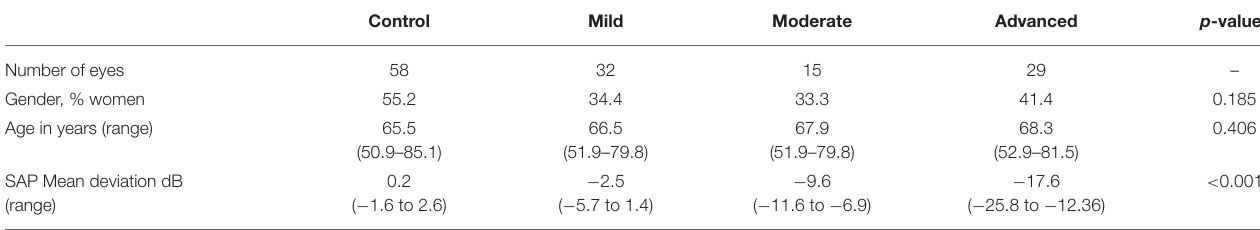
TABLE 1 | Demographic characteristics of the included